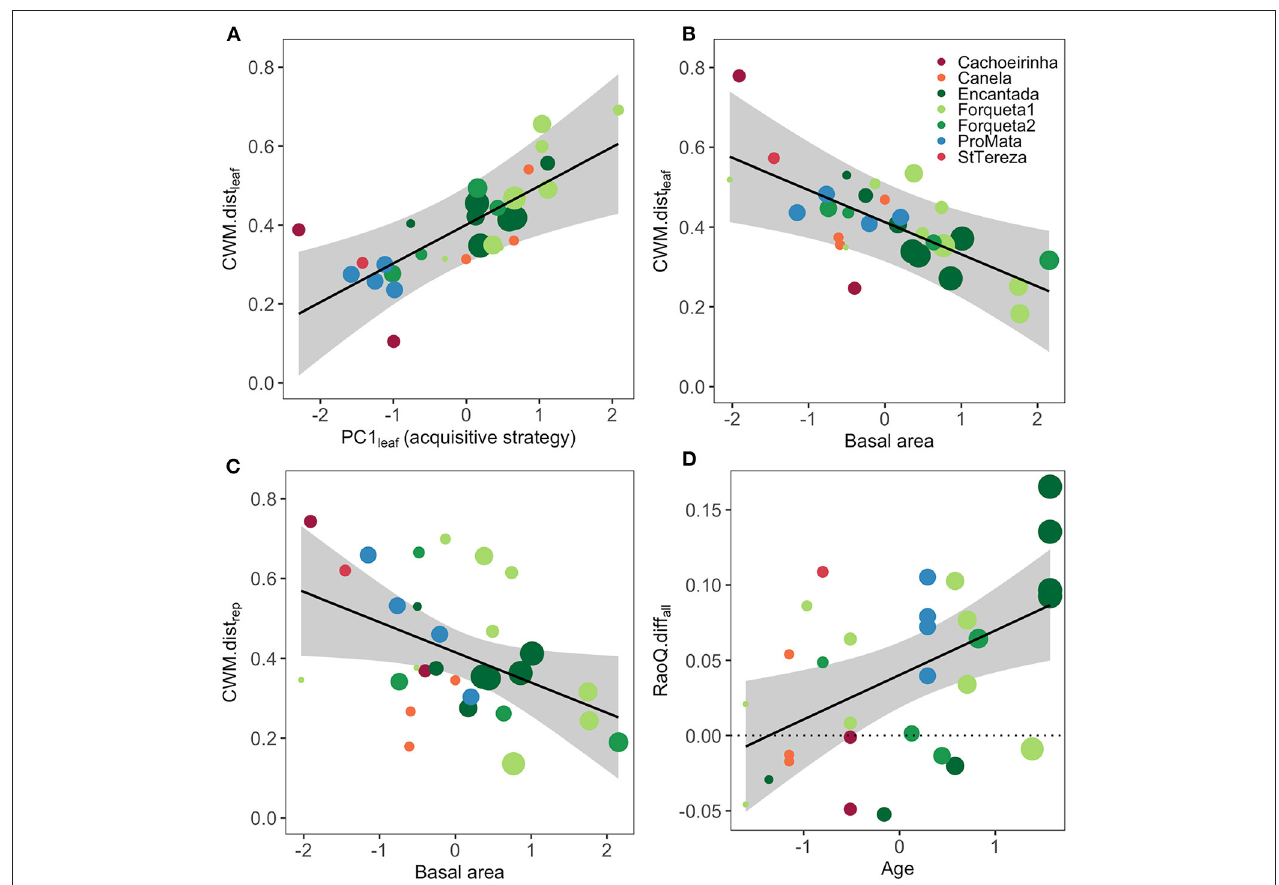
FIGURE 4 | Scatterplots of significant predictor variables of functional trait composition distances (CWM.dist) and functional diversity differences (RaoQ.diff) between the regeneration component of secondary forest stands and their reference baseline in southern Brazilian Atlantic Forest. Successional secondary forest sites are Encantada, Forqueta1, Forqueta2, and ProMata (green-blue colors), while restoration sites are Cachoeirinha, Canela, and StTereza (warm colors). Optimal models are presented in Figure 3 and Supplementary Table 5 . In plots (A–C) , values in axis y indicate the Euclidean distance between community-weighted means (CWM) of leaf traits (CWM.dist leaf ) and reproductive plus wood density traits (CWM.dist rep ) of the regeneration component of secondary forests and their respective reference baseline (i.e., comparisons were restricted to each site, see Table 1 ). In plot (D) , values in axis y indicate functional diversity differences: RaoQ.diff all = RaoQ reference -RaoQ regeneration ; values close to zero suggest similar functional diversity between the regeneration component of secondary forest and their reference baseline. Regression lines indicate significant associations ( p < 0.05; see Supplementary Table 5 ). Circle sizes indicate an increase in the regeneration age of each forest